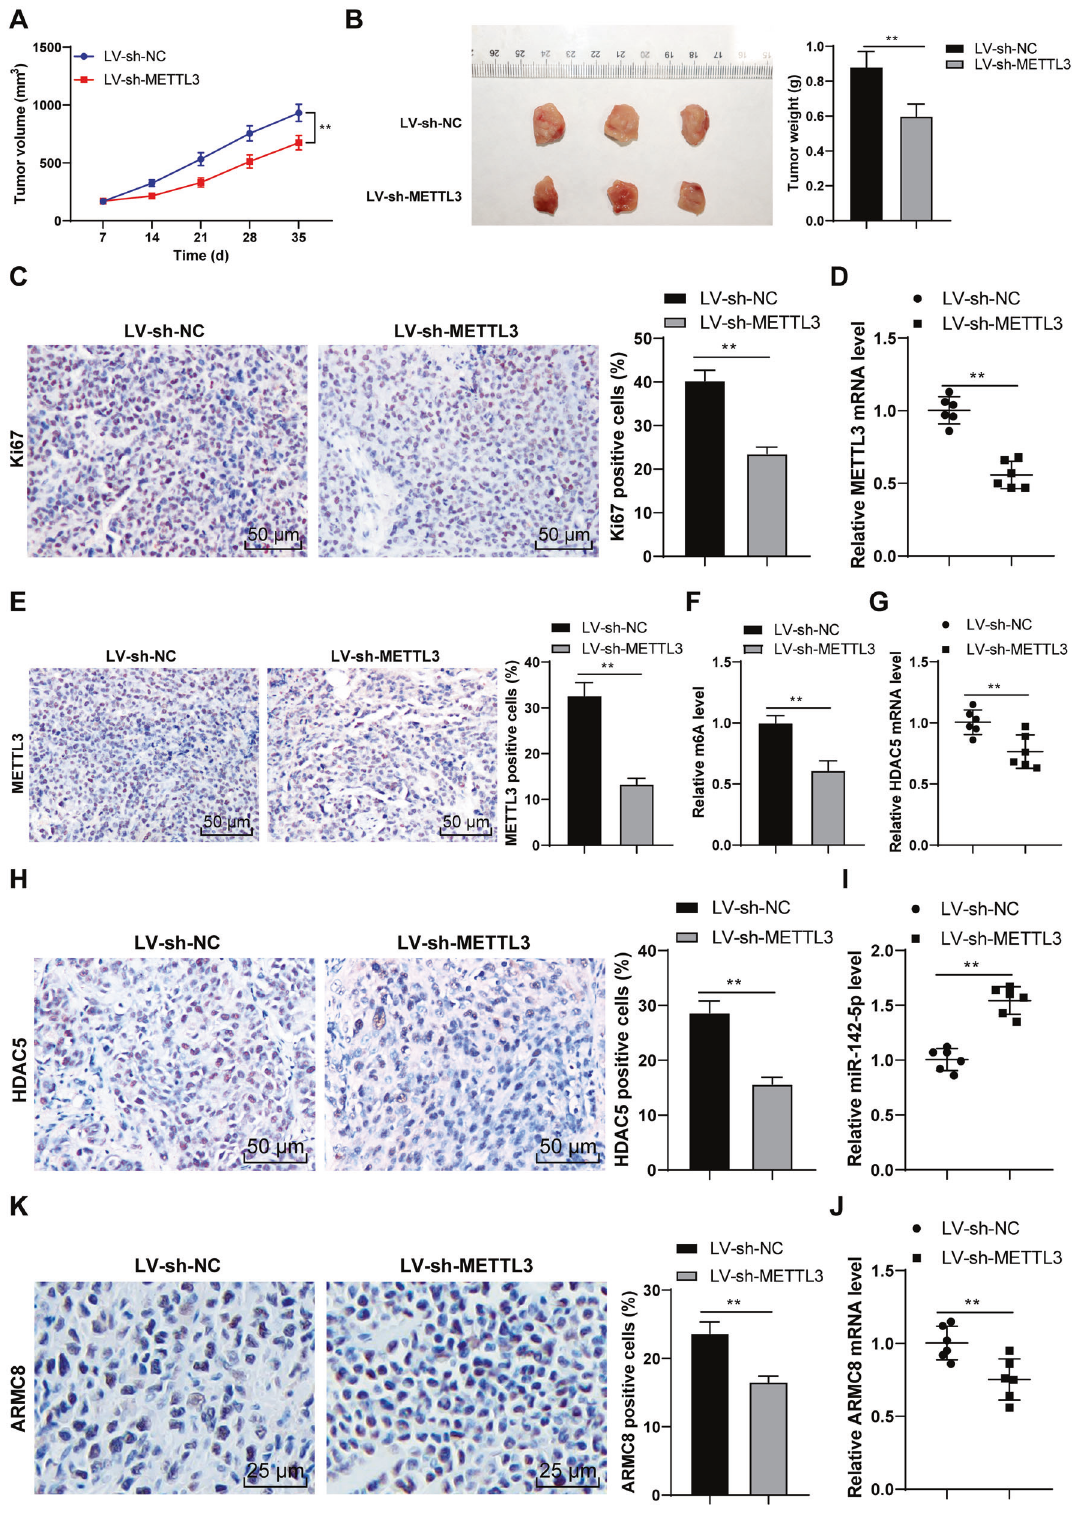
Fig. 8 METTL3 silencing suppressed OS proliferation in vivo via the HDAC5/miR-142-5p/ARMC8 axis. The xenograft tumor model in nude mice was established with U2OS cells stably low-expressing METTL3. A Tumor volume recorded every week. B After the nude mice were euthanized on the 35th day, the tumor weight and representative images were presented. C The positive rate of Ki67 was detected using immunohistochemistry. D , E METTL3 level was determined using RT-qPCR and immunohistochemistry. F m 6 A level was quantitatively analyzed. G , H HDAC5 level was determined using RT-qPCR and immunohistochemistry. I , J miR-142-5p and ARMC8 level was determined using RT-qPCR. K ARMC8 level was detected using immunohistochemistry. N = 6. The cell experiment was repeated three times independently. Data in panels A – C / E , F / H are presented as mean ± standard deviation. Data in panels B – K were analyzed using t -test. Data in panel A were analyzed using two-way ANOVA, followed by Tukey ’ s multiple comparisons test, ** p < 0.01. Cell Death Discovery (2022)